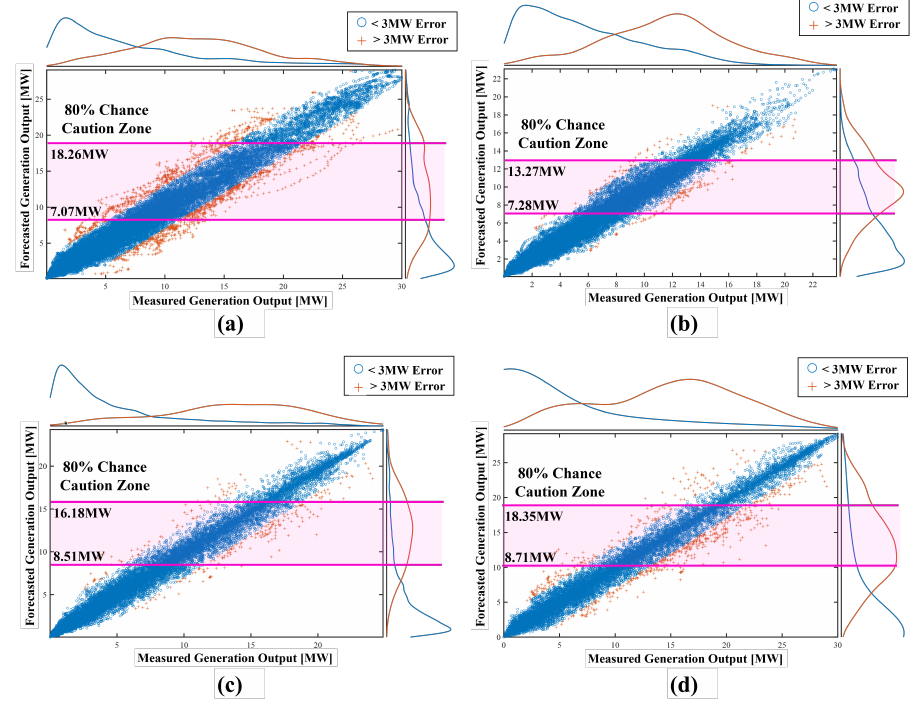
Figure 8. Joint distribution of measured and forecast generation output for ( a ) case 1, ( b ) case 3, ( c ) case 4, and ( d ) case